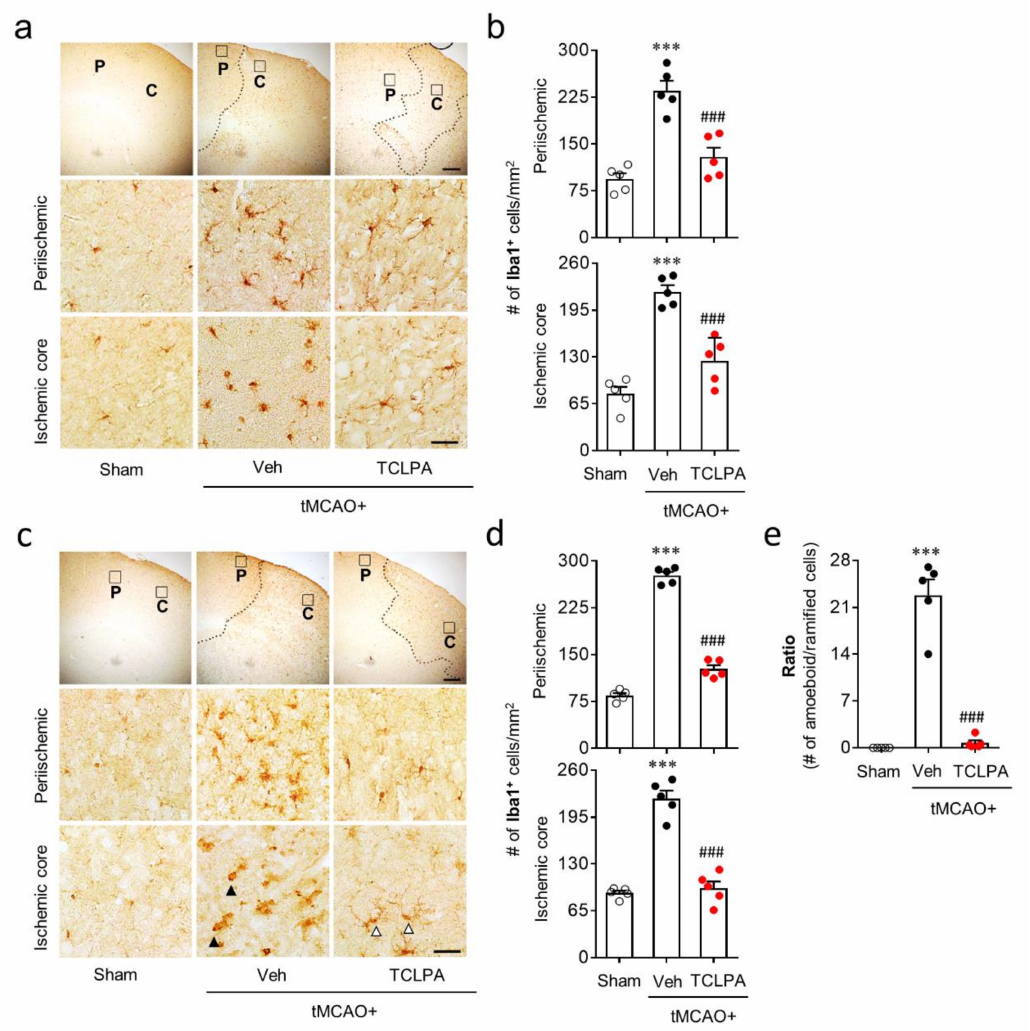
Figure 4. LPA 5 antagonism attenuates microglial activation in the injured brain after tMCAO challenge. Mice were challenged with tMCAO. TCLPA5 (TCLPA: 10 mg / kg, i.p.) was administered immediately after reperfusion, and microglial activation was determined by Iba1 immunohistochemistry at one and three days after tMCAO challenge. ( a , b ) The e ff ects of TCLPA5 on microglial activation were assessed one day after tMCAO challenge. ( a ) Representative images of Iba1-immunopositive cells in periischemic (“P”) and ischemic core (“C”) regions. Diagram boxes in upper panels display cerebral areas from which images in middle and bottom panels were obtained. Dotted lines separate periischemic